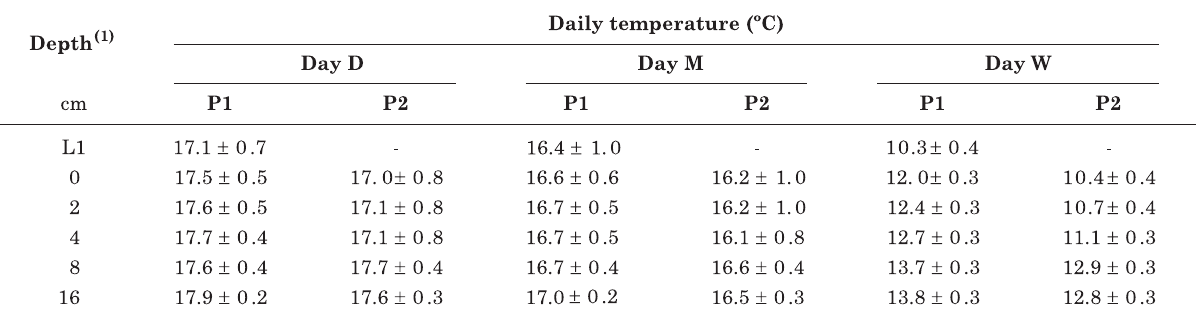
Table 2. Mean and standard deviation values of average daily temperatures in soil profiles P1 and P2, on